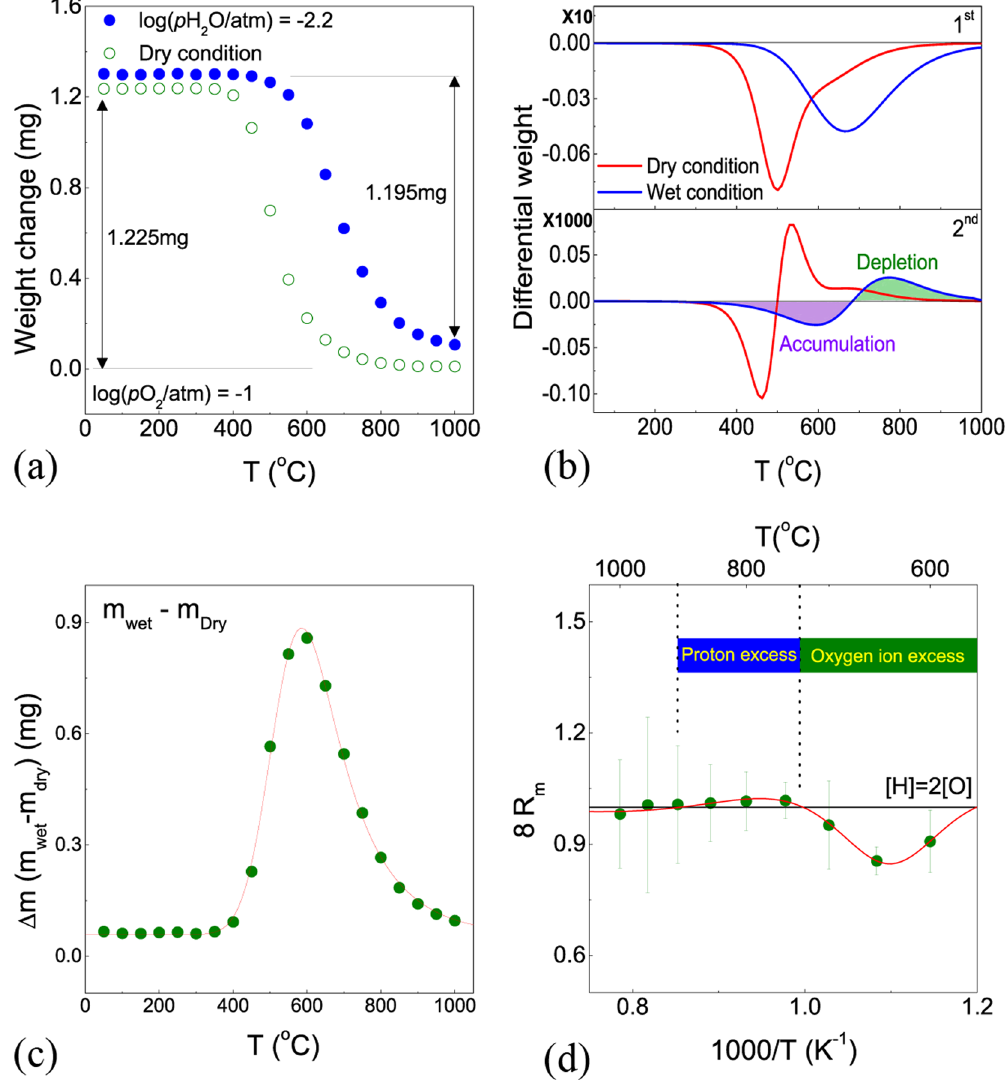
Figure 1. ( a ) Weight change, ( b ) differential weight of BCY10, ( c ) difference in weight between dry ( p H 2 O = 4.0 × 10 − 5 atm) and wet ( p H 2 O = 0.0063 atm) conditions, and ( d ) relative reaction concentrations, R m , using B k (k = i, v) from TGA mass relaxation upon hydration as functions of